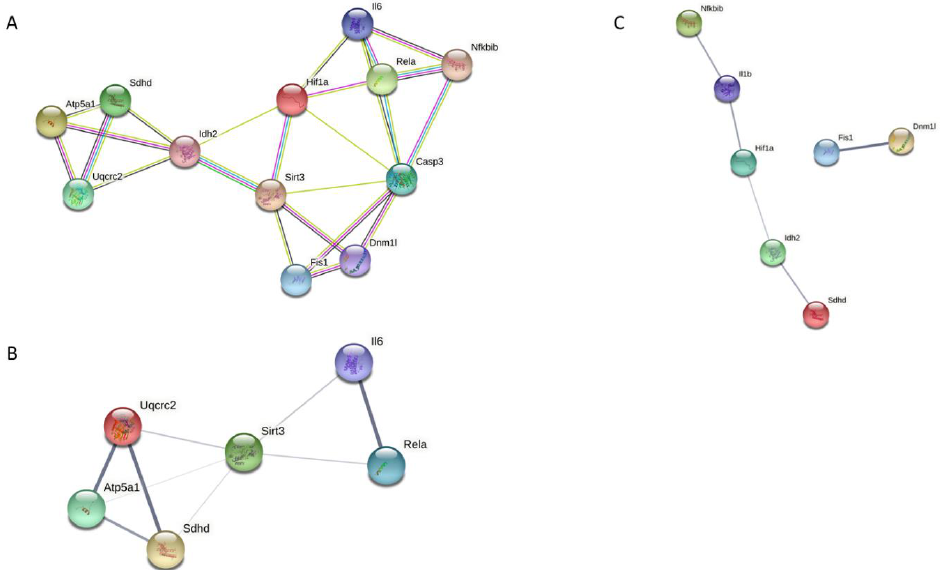
Figure 8. PPIs networks. ( A ) Network showing PPIs among genes and proteins differentially expressed in both sexes. ( B ) Network showing PPIs among genes and proteins differentially expressed in females. Thickness of edges represents the strength or confidence of data. ( C ) Network showing PPIs among genes and proteins differentially expressed in males. Thickness of edges represents the strength or confidence of data.